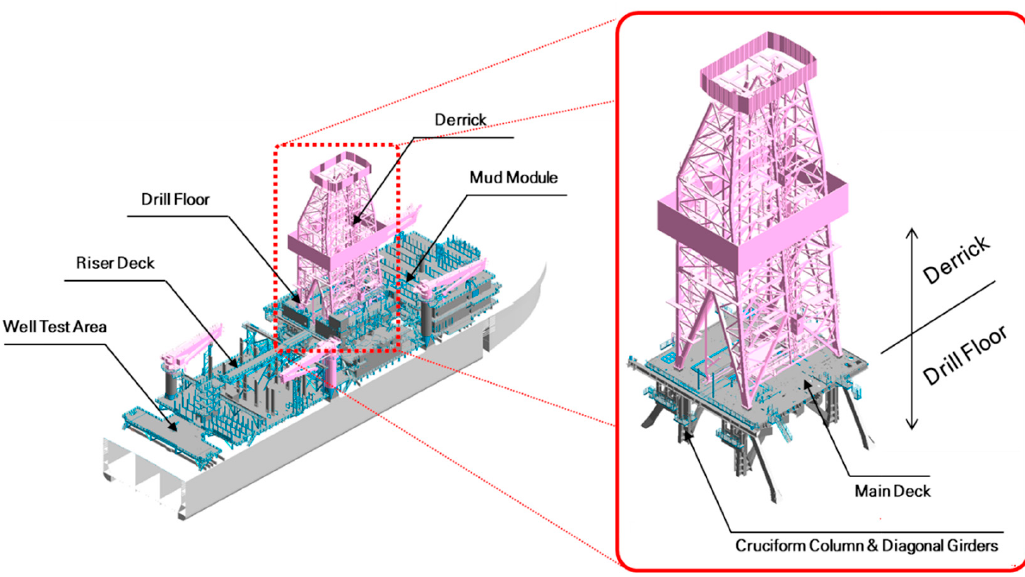
Figure 1. Overview of drillship and drill floor.